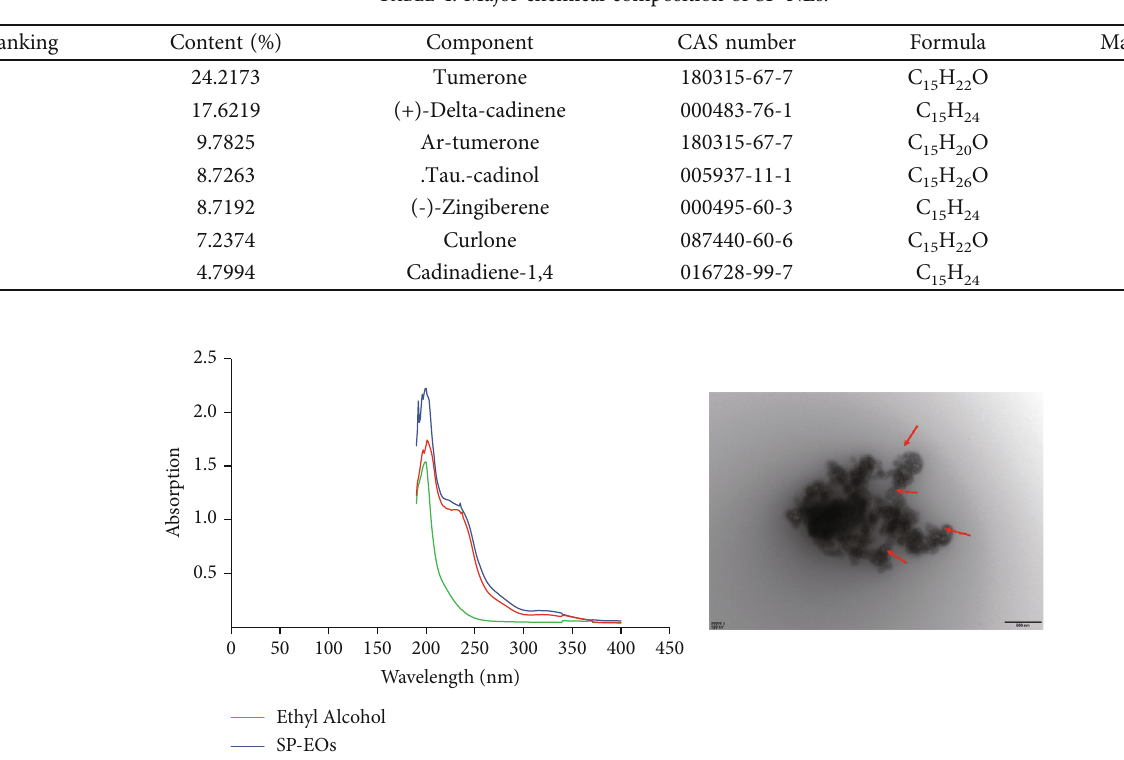
Table 4: Major chemical composition of SP-NEs.